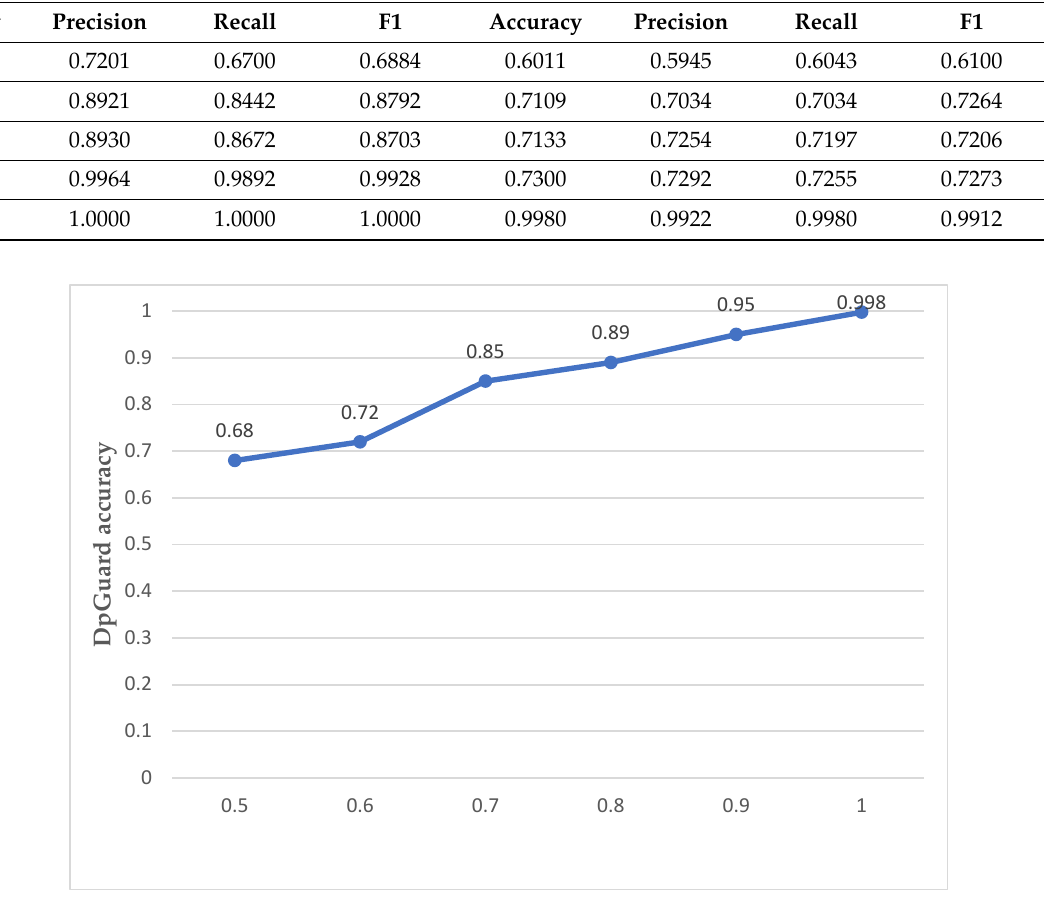
Figure 6. Effect of the selection of θ on the accuracy of DpGuard detection.